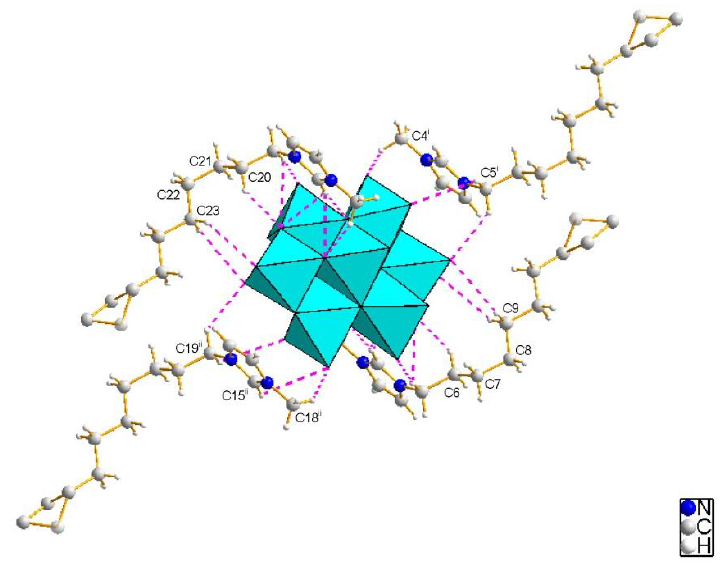
Figure 2. C–H···O hydrogen bonds in C hydrogen bonds between Mo (i) x , −1 + y , z ; (ii) x , 1 + y , z ]. Na + and 1-BuOH are omitted for clarity. Minor parts of the disordered C atoms are indicated in transparent